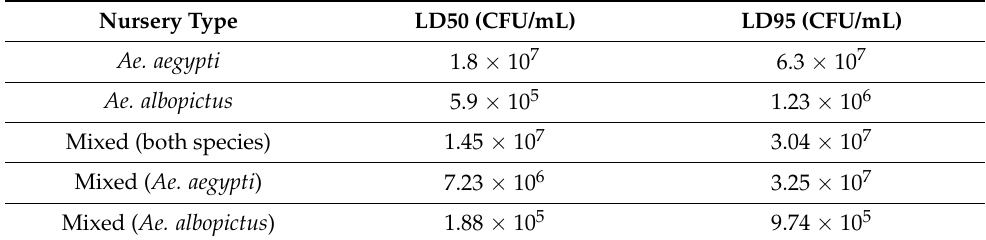
Table 2. Lethal Lysinibacillus sphaericus bacterial mixture (III(3)7 + 2362) doses for each of the treatment nurseries.